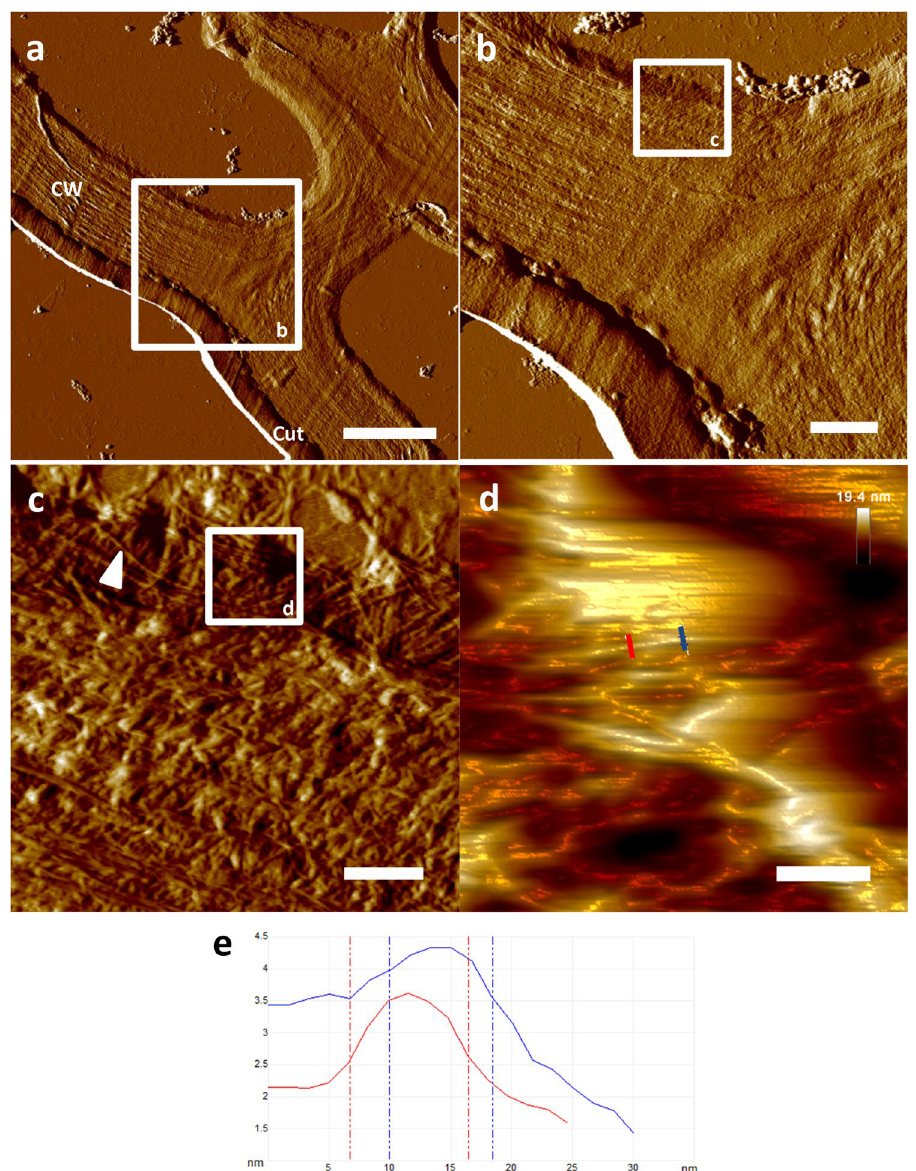
Figure 5. AFM-based ultrastructural analysis of the epidermal cell wall of Senna alexandrina (Fabaceae) leaves. AFM-data acquisition on cell wall ultra-sections allowed nanoscopic resolution down to the microfibril level. ( a – c ) Low, medium and high magnification amplitude data of Senna alexandrina cell wall morphology. Note the clear depiction of the layered cell wall composition and the resolution of single macro- as well as microfibrils (white triangle). ( d ) High resolution height data of single microfibrils (3D representation). ( e ) Section analysis of a single microfibril showing lateral dimensions of just below 10 nm. Note the corresponding z-axis resolution below 0.5 nm. Scale bars ( a ) 4 µm, ( b ) 1 µm, ( c ) 320 nm, ( d ) 100 nm. Cut cuticle, CW cell wall, white triangle isolated